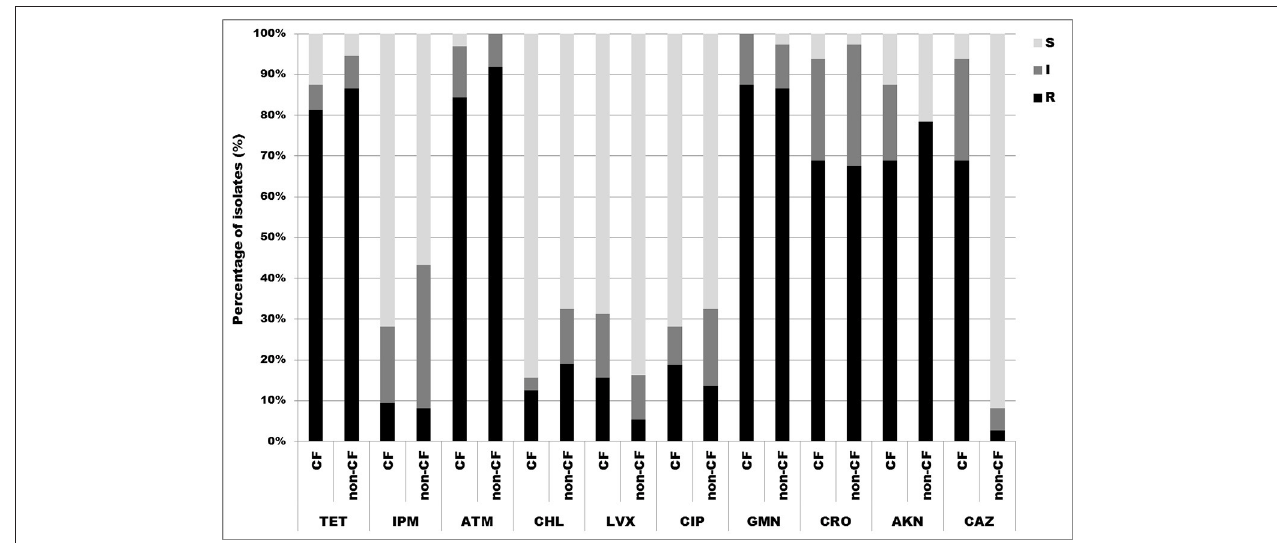
FIGURE 3 | Distribution of antibiotic resistances among CF and non-CF Achromobacter spp. isolates determined by disk diffusion method. TET, tetracycline; IPM, imipenem; ATM, aztreonam; CHL, chloramphenicol; LVX, levofloxacin; CIP, ciprofloxacin; GMN, gentamicin; CRO, ceftriaxone; AKN, amikacin; CAZ, ceftazidime; S, sensitive; I, intermediate; R, resistant.